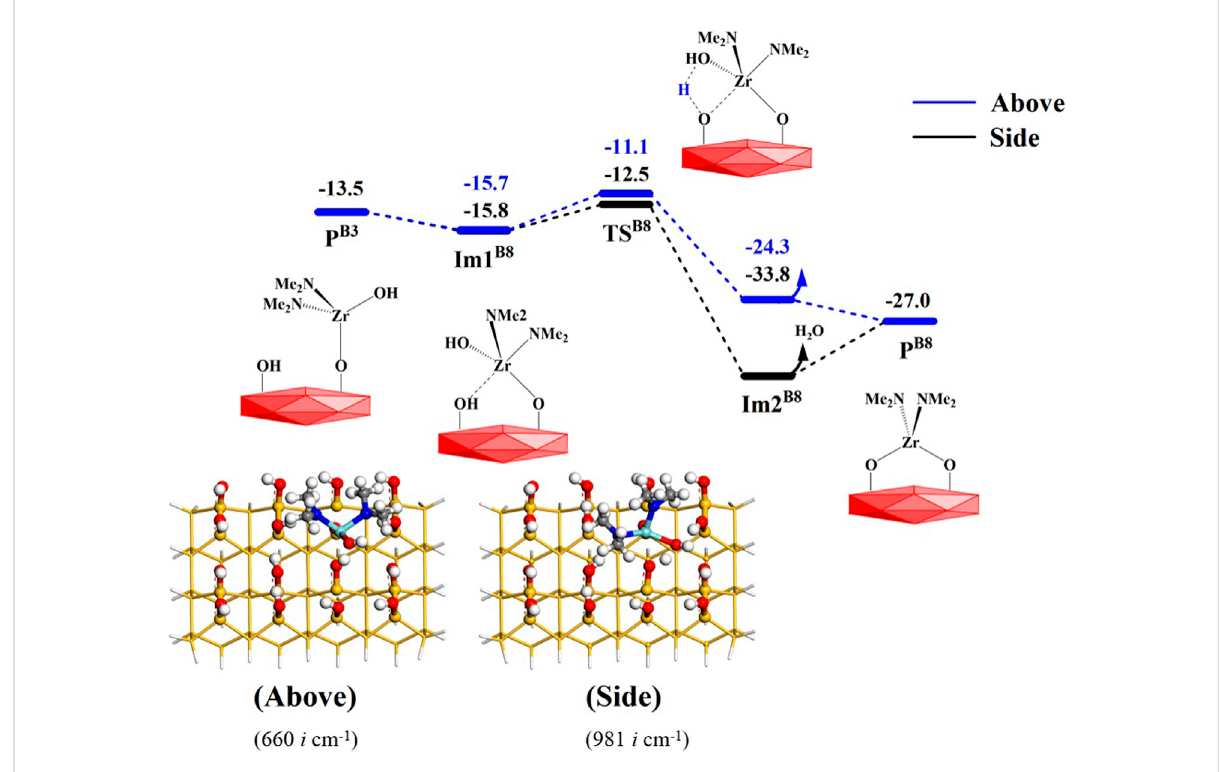
FIGURE 12 Gibbs free energy ( Δ G , kcal/mol) pro fi les of the B8 section of the H 2 O reaction with the aminated surface.